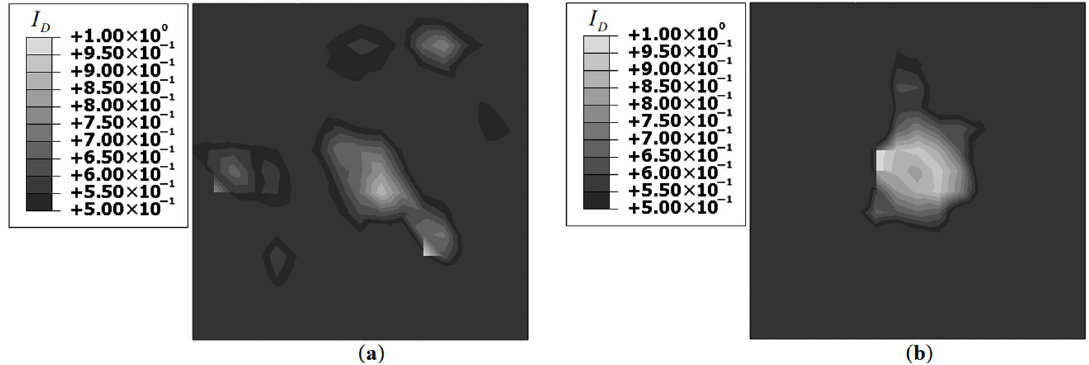
Figure 20. iFEM reconstructed I D distribution for Damage Case-3 (5% noise) using: ( a ) Unitcell-1, and ( b ) Unitcell-2.